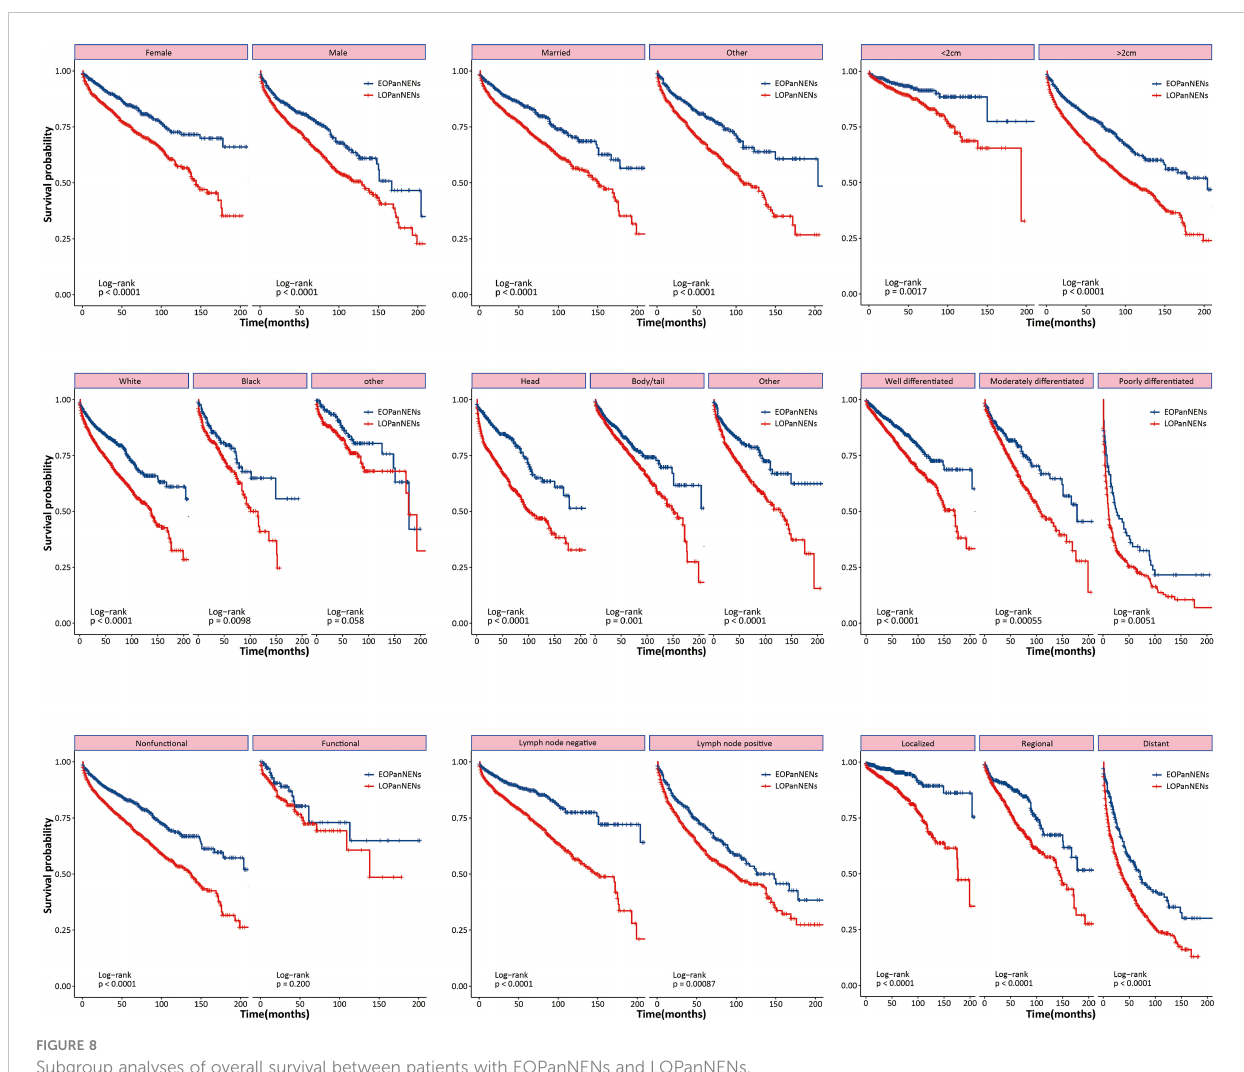
FIGURE 8 Subgroup analyses of overall survival between patients with EOPanNENs and LOPanNENs.